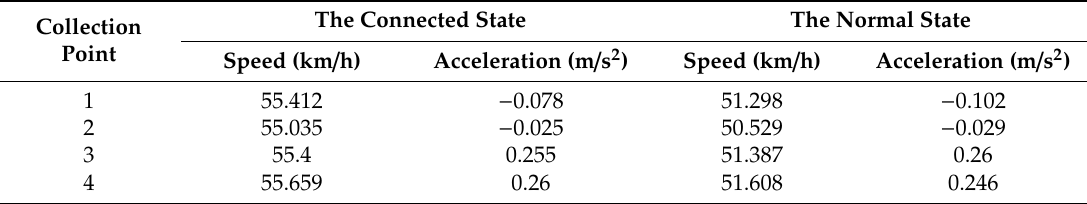
Table 3. Average speed and acceleration in two cases.